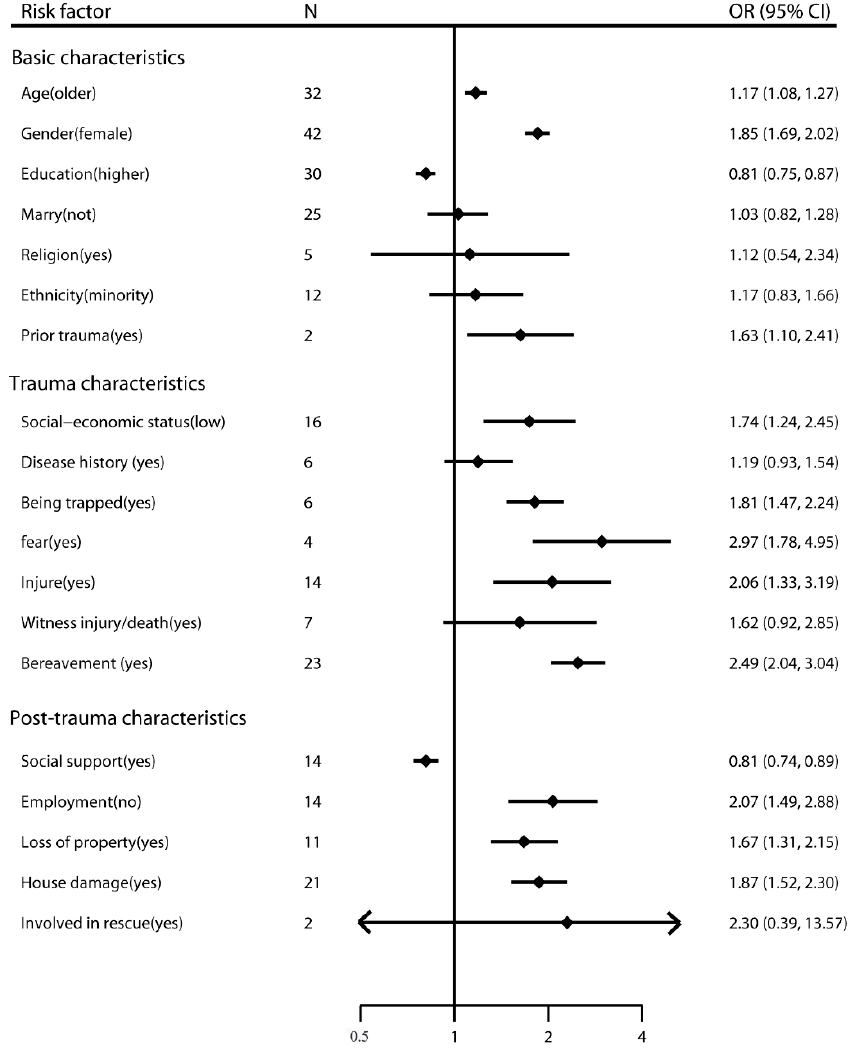
Figure 2. Risk factors for PTSD after earthquake in adults.